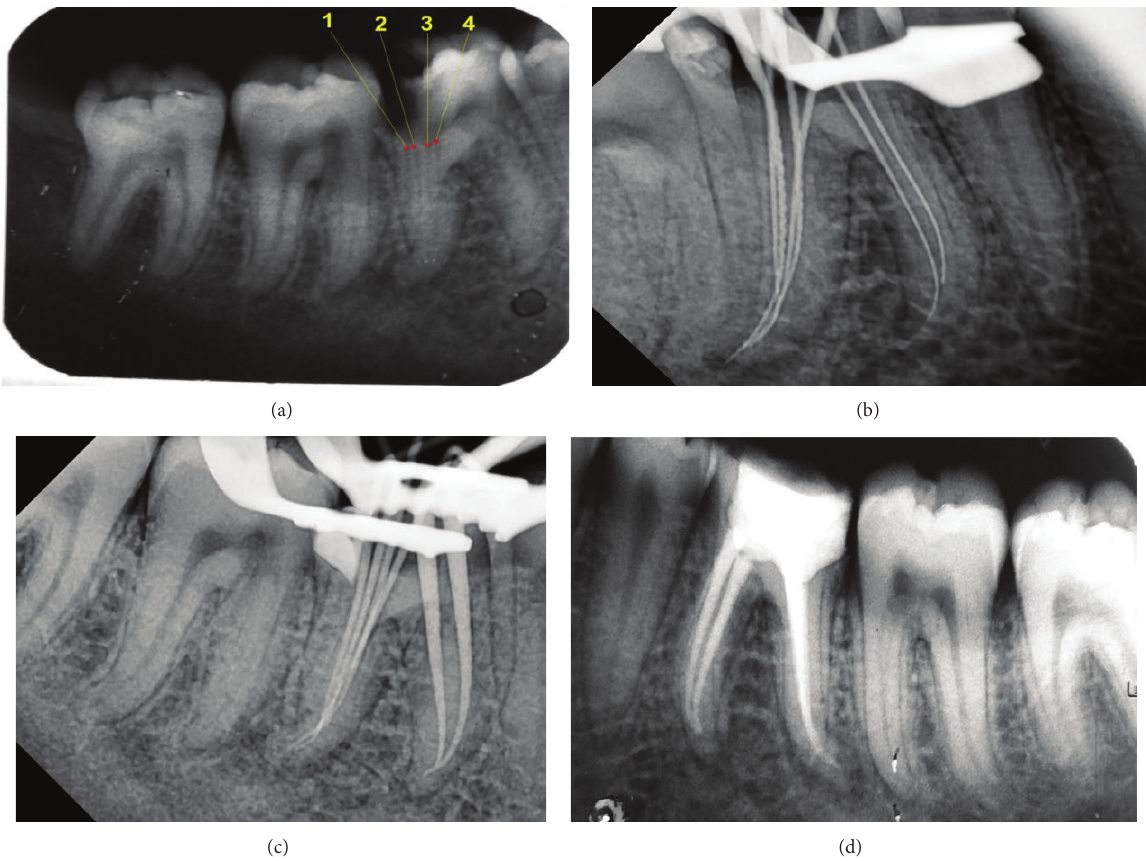
Figure 1: (a) Preoperative intraoral periapical radiograph 1-distobuccal I, 2-distobuccal II, 3-middistal, and 4-distolingual. (b) Radiograph showing working length determination of six root canals. (c) Master cone radiograph. (d) Postobturation